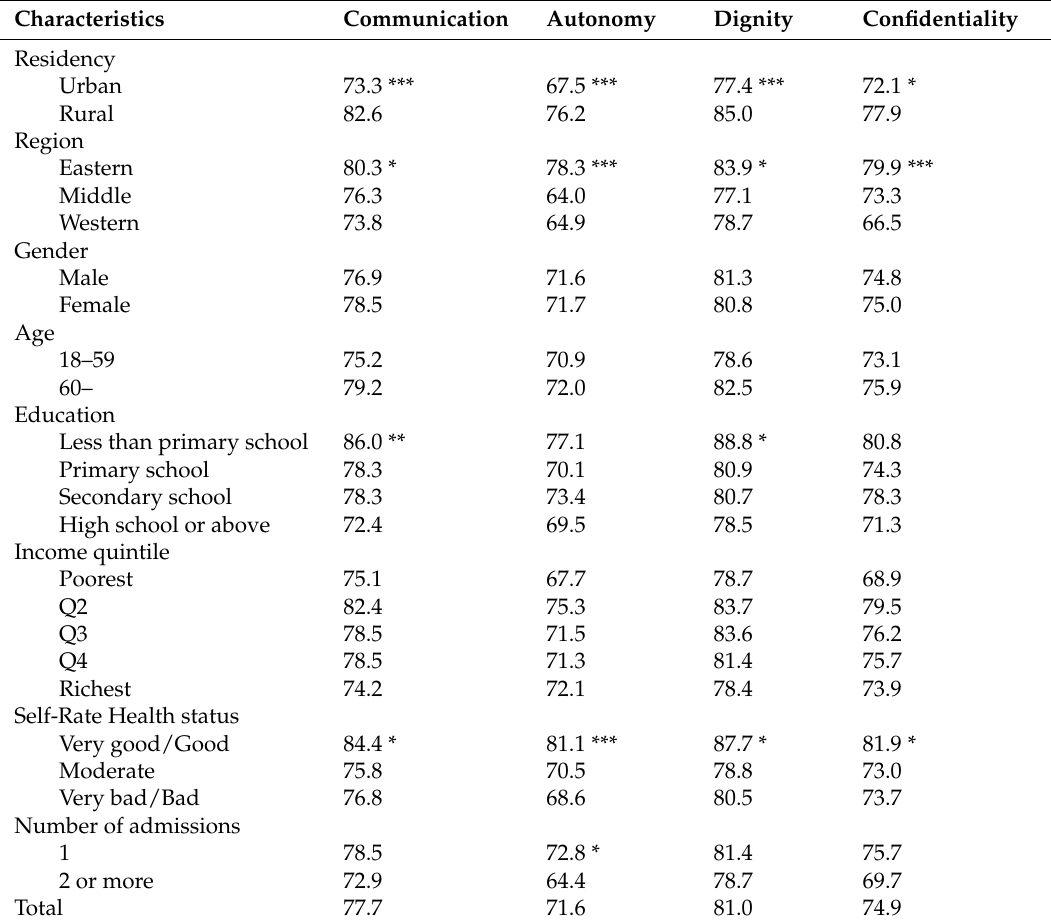
Table 2. Percentage (%) of respondents reporting Very good/Good in each